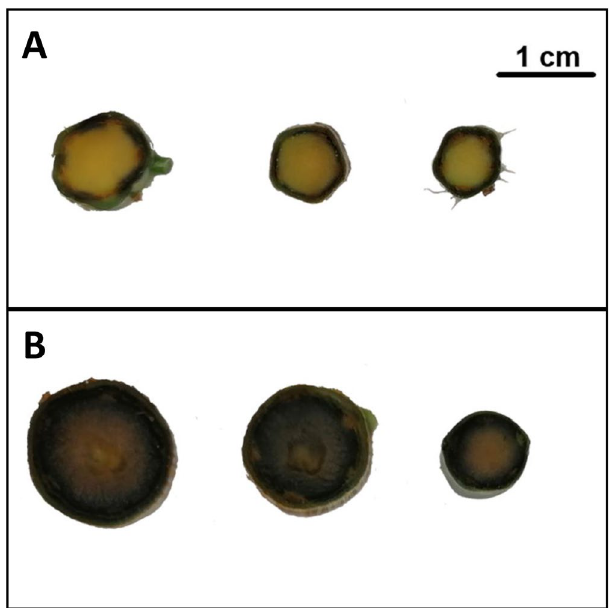
Figure 2. Transverse view of the stems of wild ( A ) and domesticated ( B ) plants stained with Lugol’s solution. Dark-blue areas indicate the presence of starch. The three stem sections show the variation in terms of size and staining patterns observed within the sample of wild ( A ) and domesticated plants ( B ).